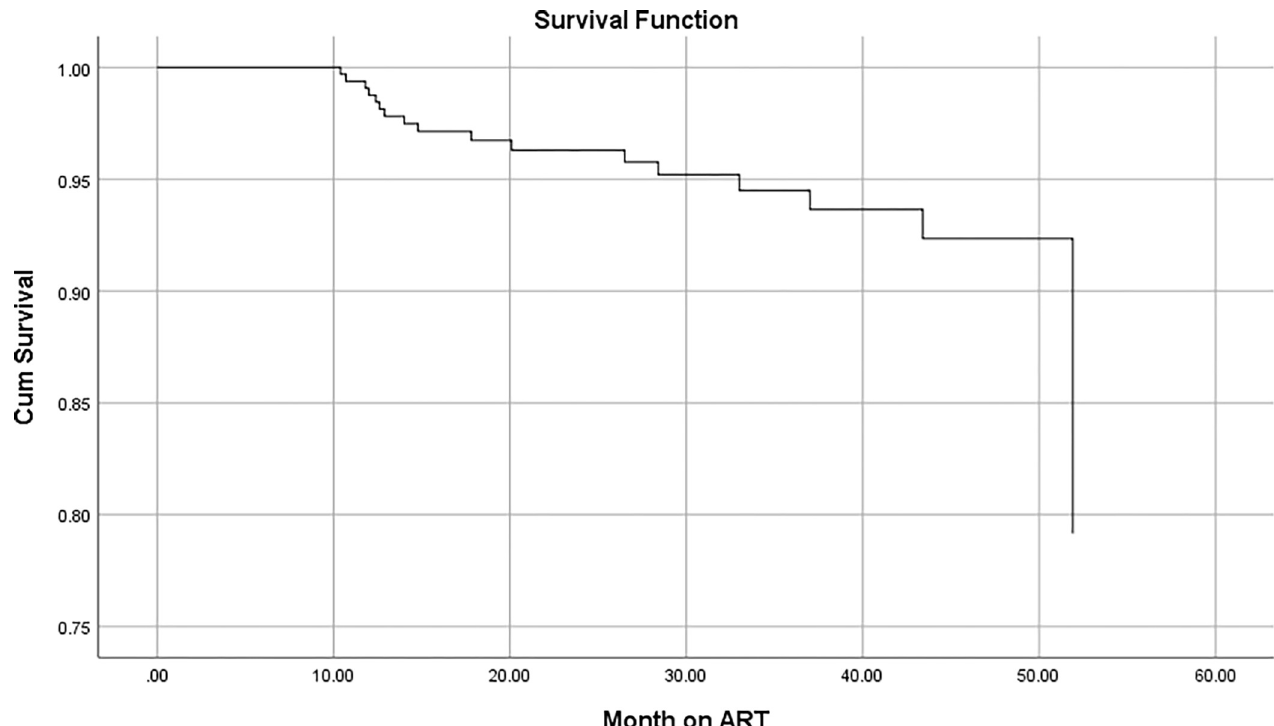
Fig 2. Kaplan-Meier’s survival graph of patients on ART in St. Paul’s hospital millennium medical college from July 2016 to December 2020.